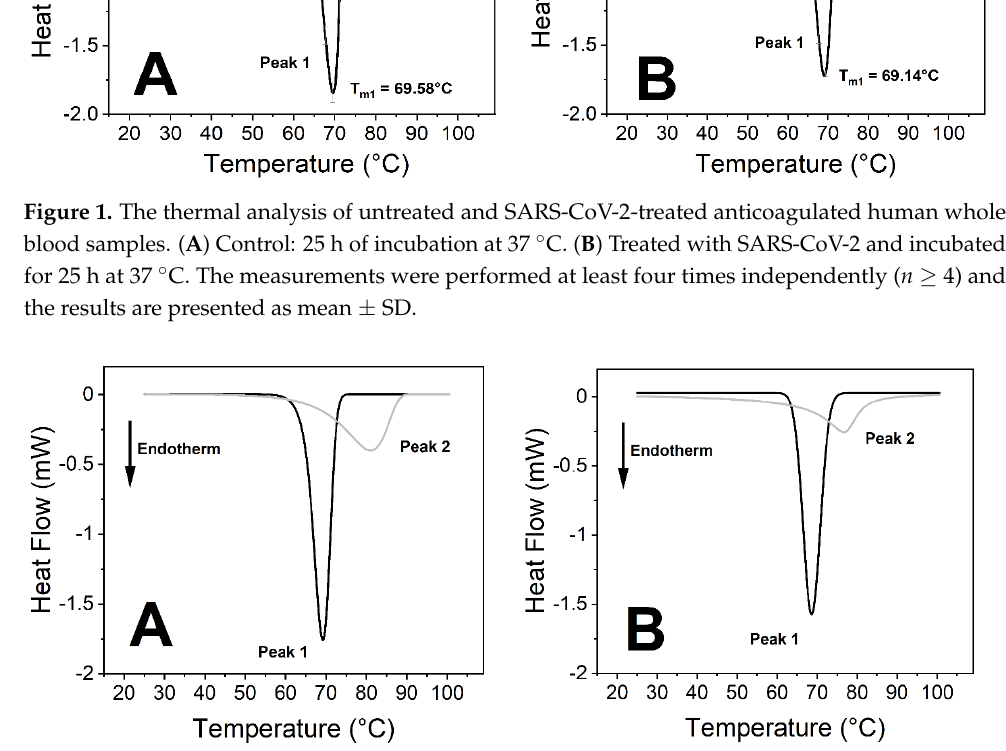
Figure 2. Deconvolution of peak 1 and peak 2 from Figure 1 DSC plots. ( A ) Control: 25 h of incubation at 37 °C. ( B ) SARS-CoV-2 treatment: incubated for 25 h at 37 °C.